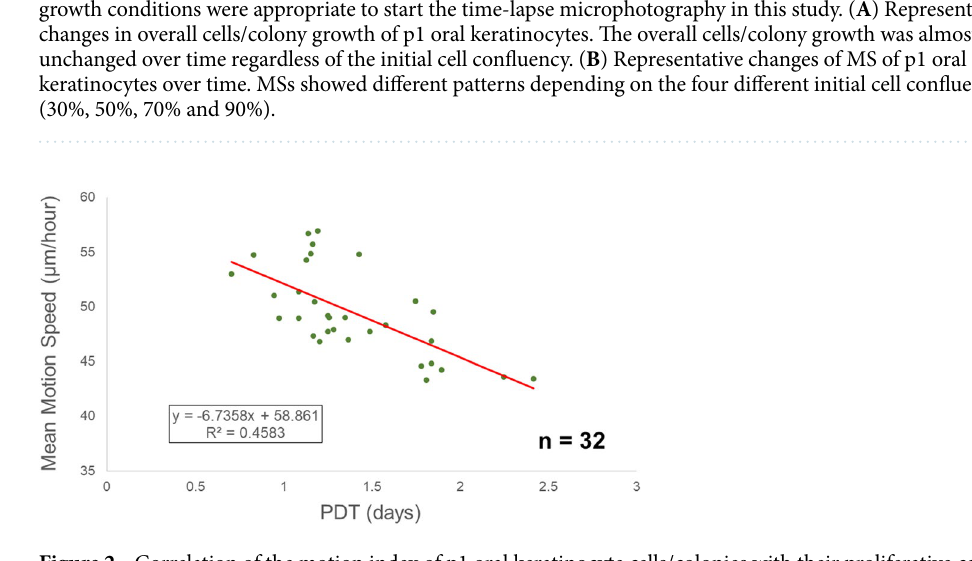
(Fig. 1B). Since the MMS is a parameter of the mean of the total frames (31), the increase and decrease of the MS during microphotography is not appropriate as the representative data of the sample. Thus, as a new protocol, the starting conditions for time-lapse microphotography when the cells reached approximately 50% confluency was set and applied to further measurements used in this study. Using the same OF algorithm as our previous report and different image segmentation, the motion behaviour of the individual p1 cells/colonies was successfully quantified, which indicated that MS can be applicable and feasible for non-invasive and quantitative measurements of the cells/colony motion (Fig. S1 in the Supplementary Information). The sum of the MS of the total 31 frames was divided by the 31 results in MMS (μm/hour), which produced a representative MS for the p1 cells. Validation of the OF algorithm used in this study was completed in the previous study by showing manual tracking of individual cells 29 . Correlation of the proliferative capacity of p1 oral keratinocytes with MMS using a standard protocol. When the MMSs of all 32 samples were analysed and their PDTs were plotted on a scatterplot, the diagram showed a negative linear correlation with PDT, which was statistically significant (Fig. 2) (Spearman’s r = –0.6669, 95% confidence interval = − 0.8274 to − 0.4057, p < 0.0001). Thus, oral keratinocyte p1 cells/colonies